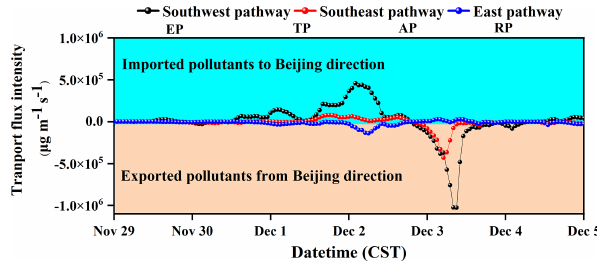
Figure 10. Time series of PM 2 . 5 transport flux intensity from differ- ent transport pathways. The corresponding directions of the south- west, southeast, and east pathways are shown in Fig.